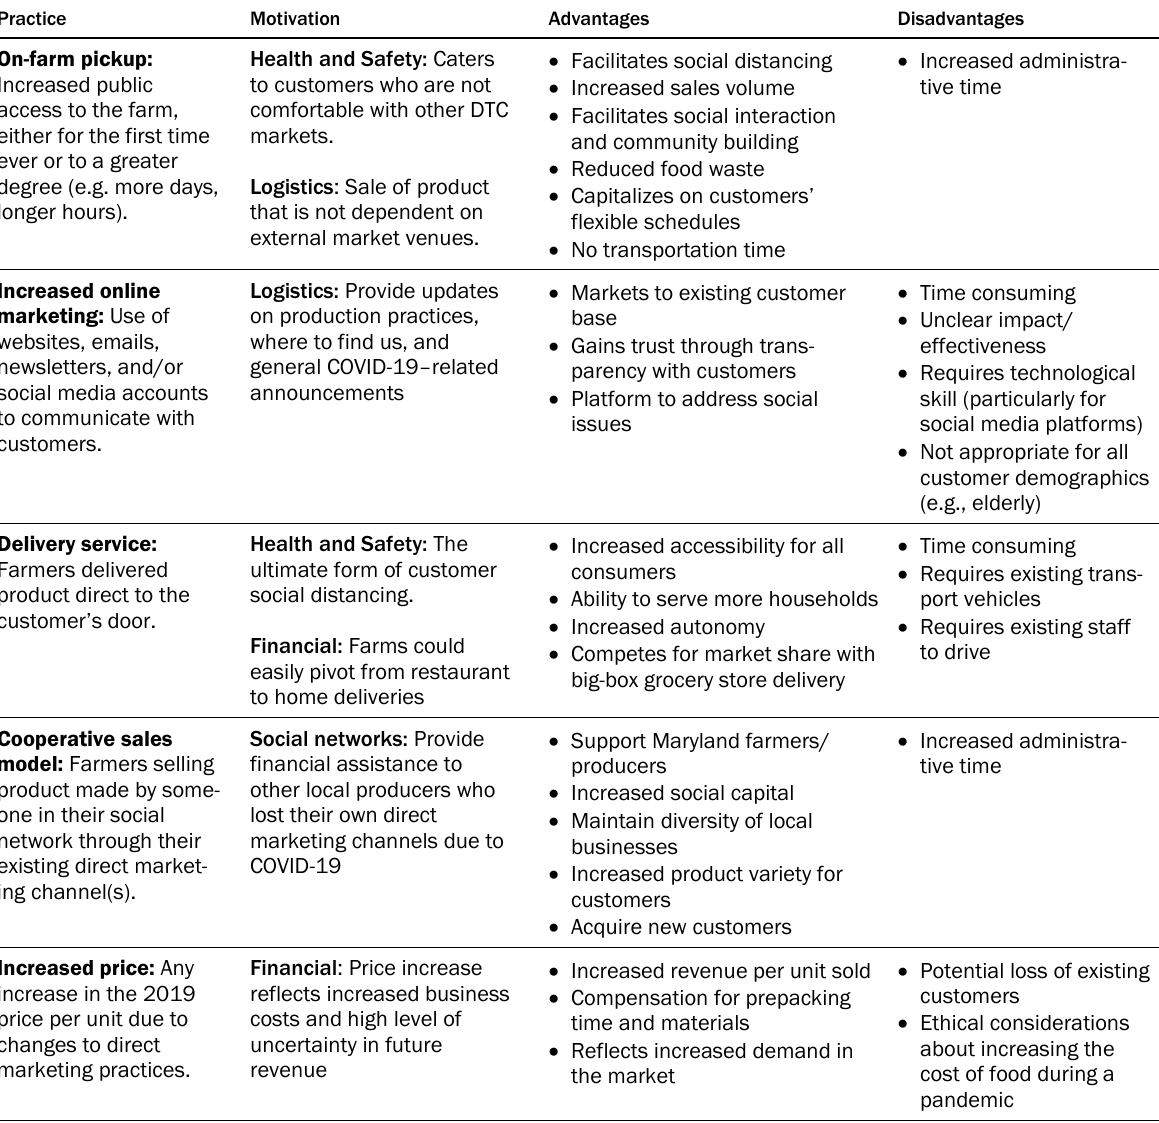
Table 3. Marketing Practices Using Existing